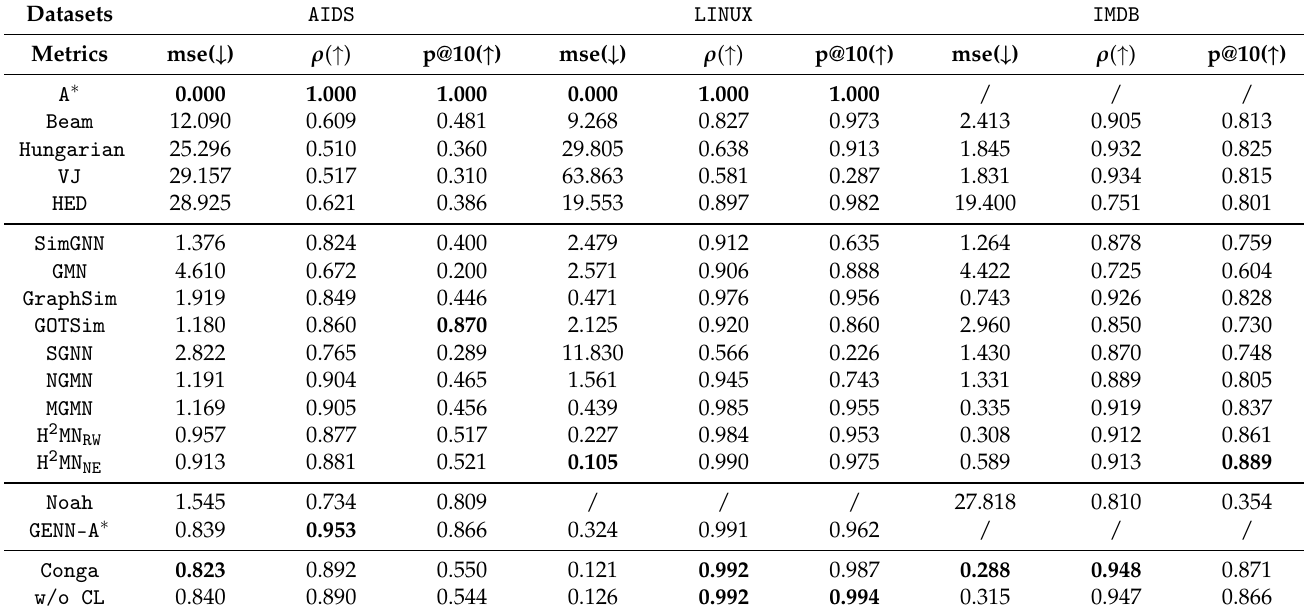
Table 3. Main experimental results (mse is in the scale of the 10 − 3 ). ↓ means lower values are preferred, while ↑ means higher values are preferred. / represents that the results cannot be obtained due to excessive running time or are not provided in the original work (and cannot be